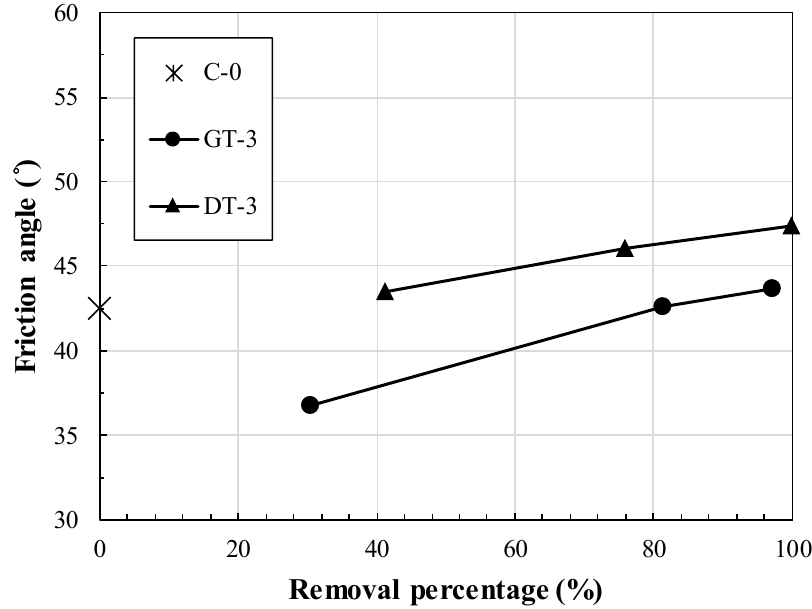
Figure 5. Comparison of the frictional angles of gasoline and diesel.